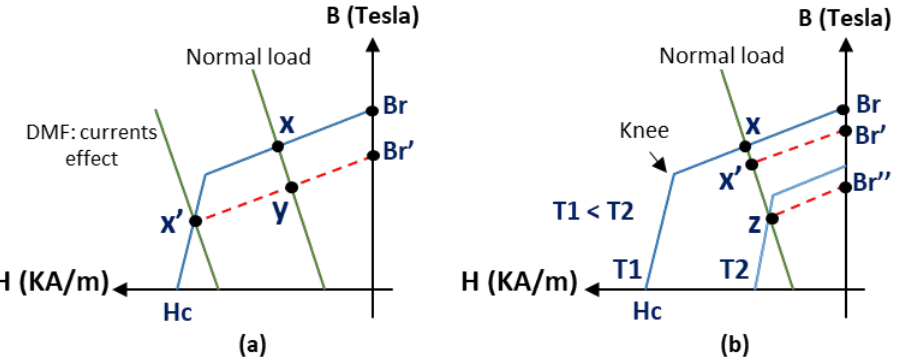
Figure 1. Irreversible demagnetization due to: ( a ) External demagnetizing magnetomotive force (MMF); ( b ) operation at a high temperature [8].